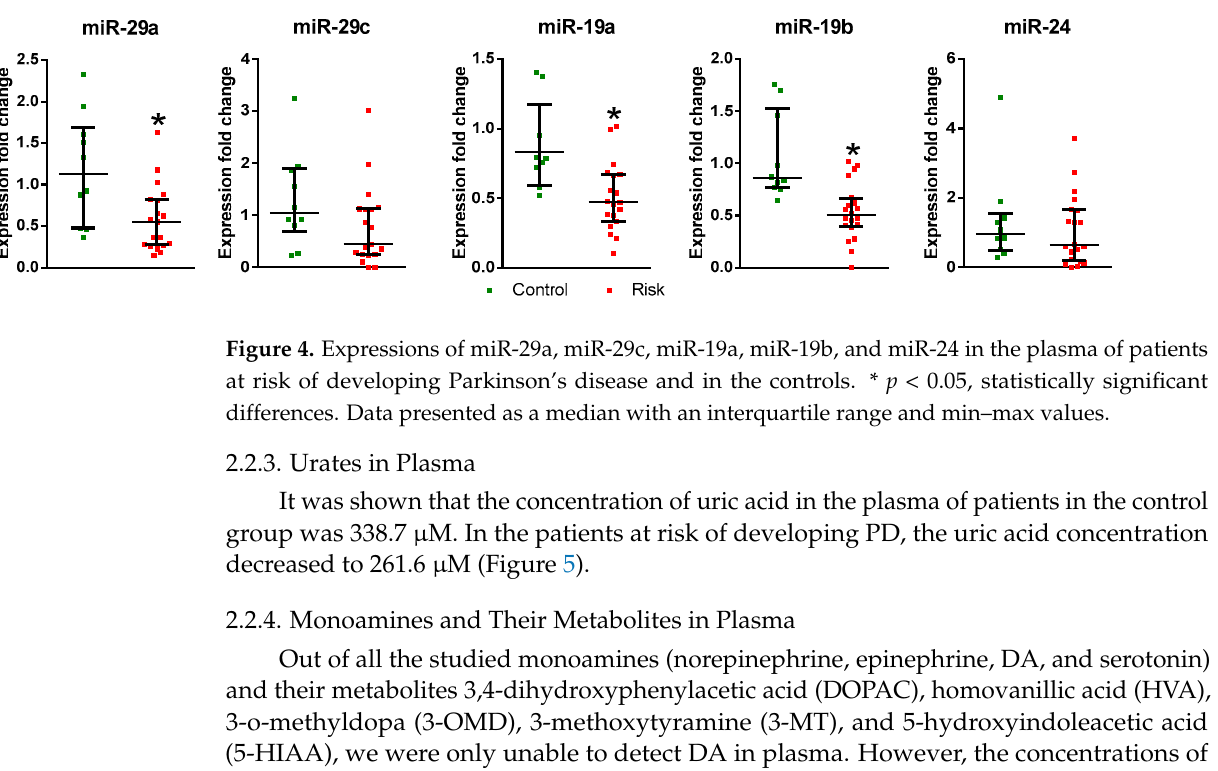
Figure 5. Plasma uric acid concentration in the patients at risk of developing Parkinson’s disease and in the controls. * p < 0.05, statistically significant differences. Data presented as a median with an interquartile range and min–max values. 2.2.4. Monoamines and their metabolites in plasma. Out of all the studied monoamines (norepinephrine, epinephrine, DA, and seroto- nin) and their metabolites 3,4-dihydroxyphenylacetic acid (DOPAC), homovanillic acid (HVA),